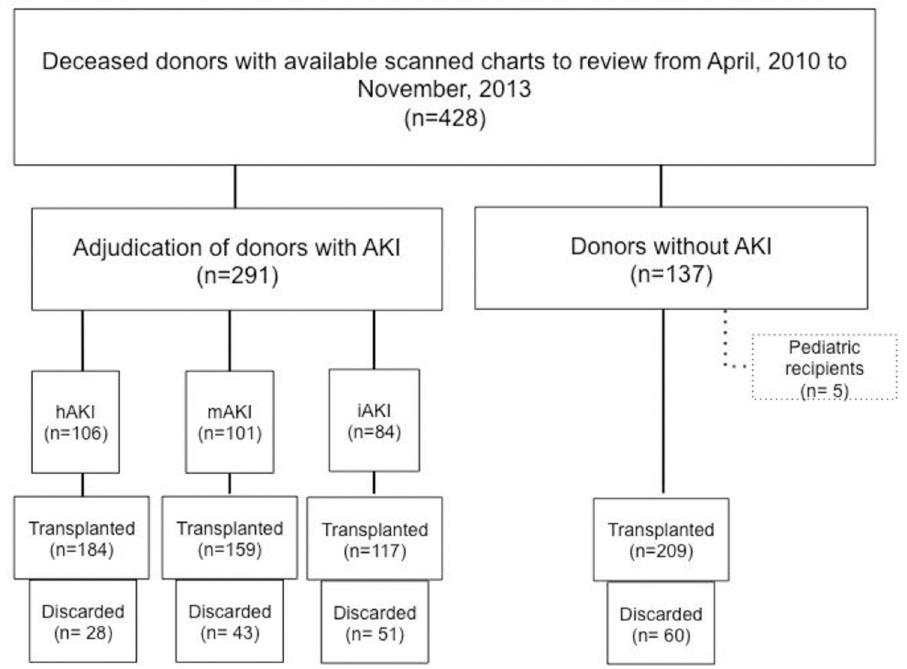
Fig 1. Study flow diagram. Shows the breakdown of our study. A total of 428 donors with available charts were included in our study. Among the 428 donors, 291 had AKI at anytime point during the hospitalization. Only donors with AKI were adjudicated, and 106 were found to have hemodynamic AKI, 101 mixed AKI and 84 intrinsic